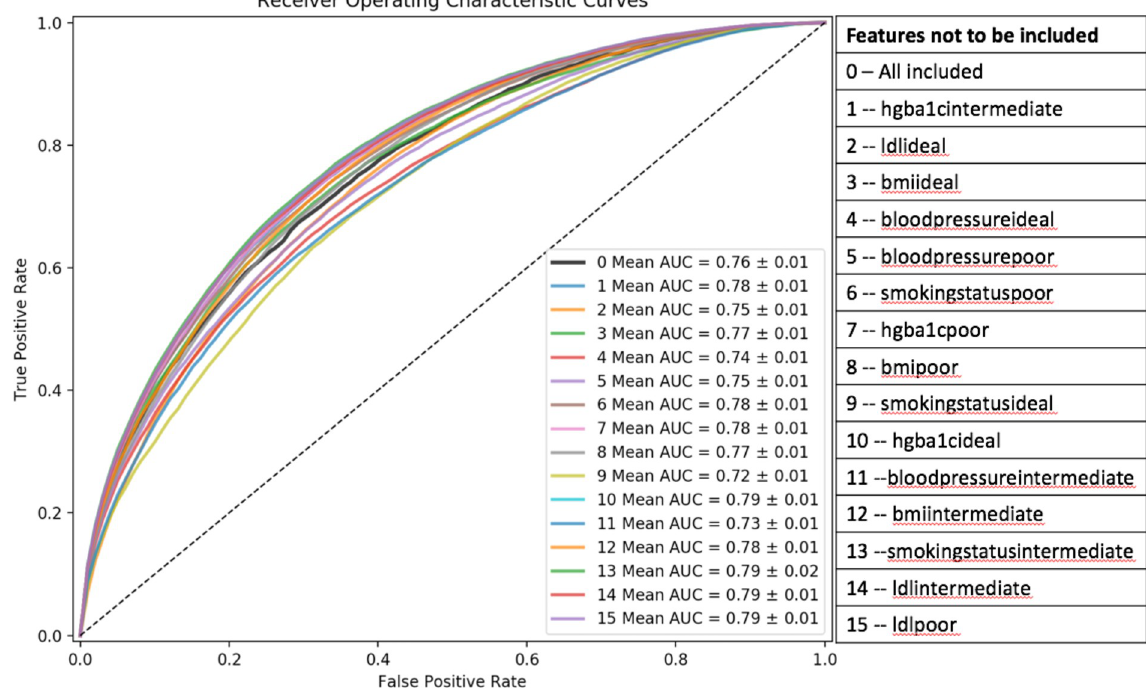
Fig 5. Feature discriminative importance evaluated using the LSTM